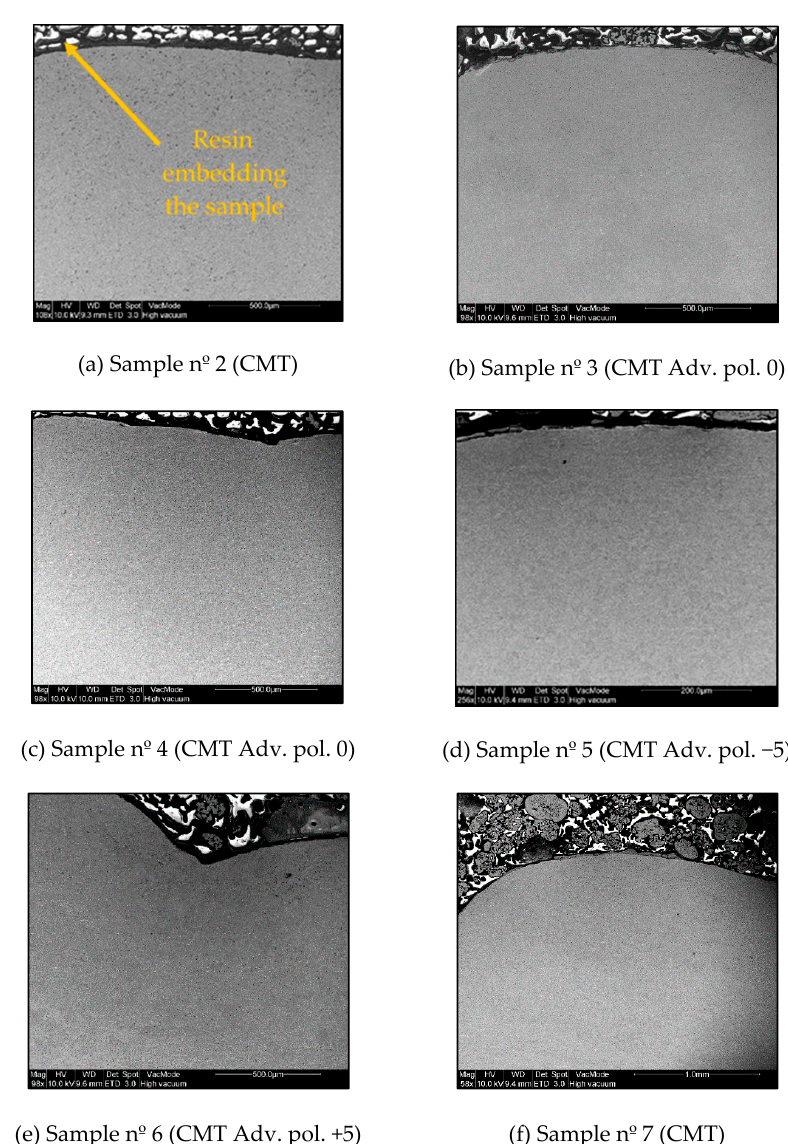
Figure A2. SEM images showing no decohesionated layer formation in the upper edge of the surface. ( a ) Sample nº 2, CMT process; ( b ) Sample nº 3, CMT Adv. pol. 0; ( c ) Sample nº 4, CMT Adv. pol. 0; ( d ) Sample nº 5, CMT Adv. pol. ‐ 5; ( e ) Sample nº 6, CMT Adv. pol. +5; ( f ) Sample nº 7, CMT Cont.